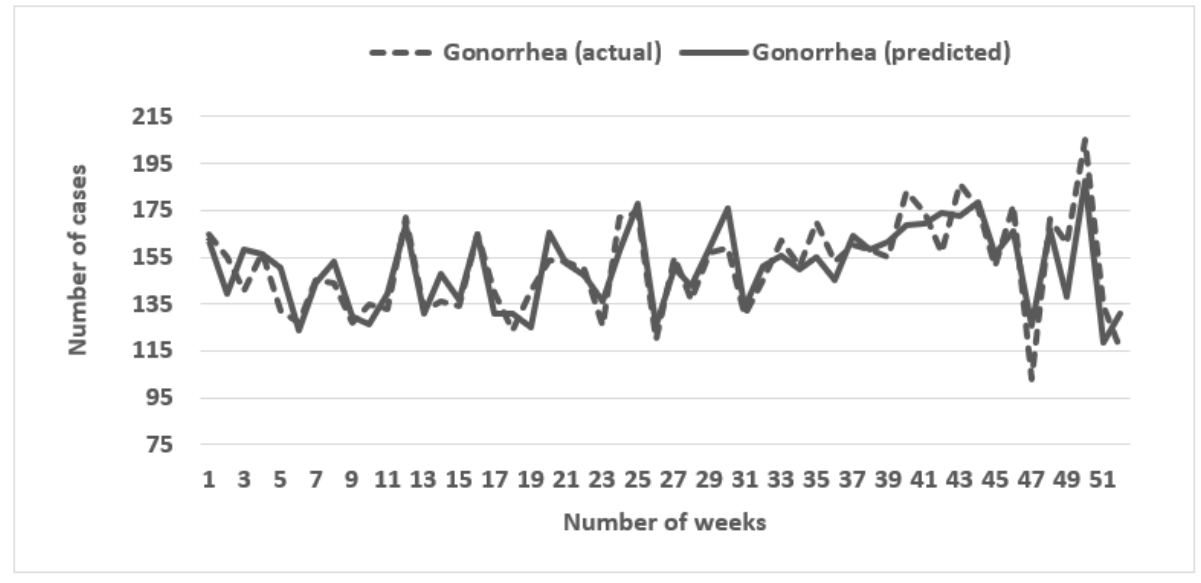
Figure 1. Graphical comparison between actual and predicted number of gonorrhea cases for